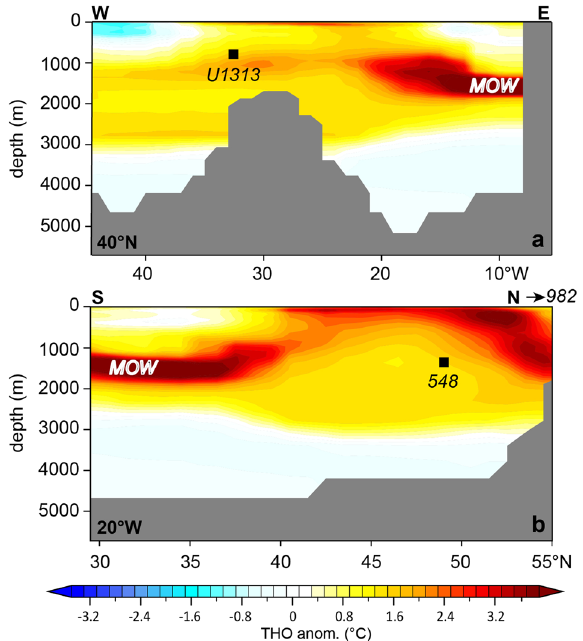
Fig. 4 Temperature anomaly (based on simulated potential seawater temperature, MPIOM variable THO) between the PlioMIP2 Pliocene background state of COSMOS and the simulation with added Newtonian salinity restoring mimicking the Mediterranean Over fl ow Water (MOW). a Intrusion along a meridional transect (30° – 55°N; 20°W) and ( b ) zonal cross-section (10° – 45°W; 40°N) of the North Atlantic. Locations of referenced data sets from Sites U1313 and DSDP548 are